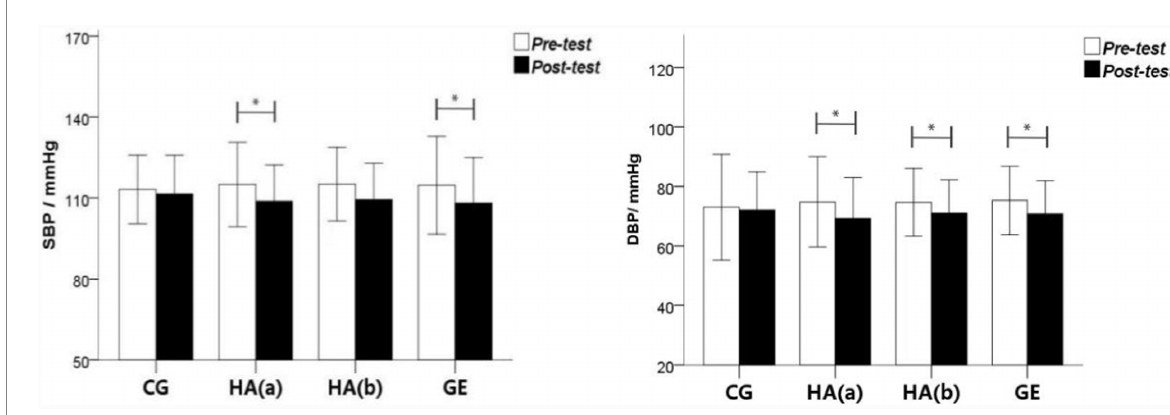
FIGURE 5 The trend of pre-test and post-test changes in SBP and